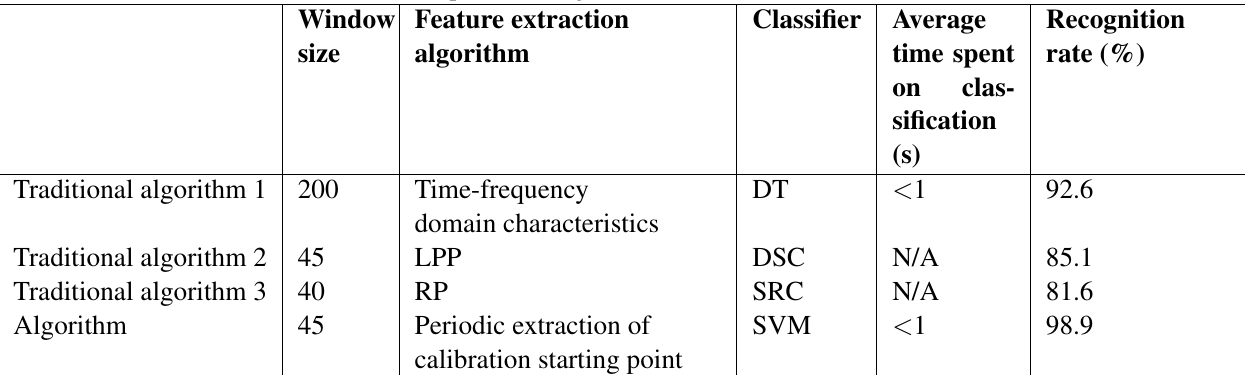
Table 3 Comparison of algorithm results based on